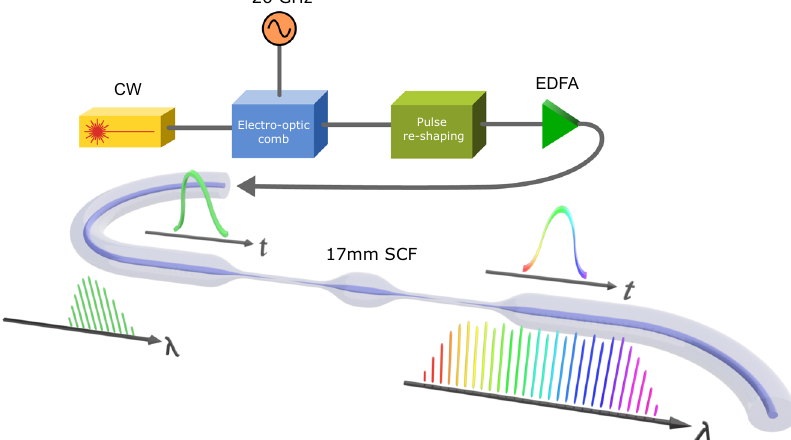
Fig. 2 Fully integrated SCF-based parametric comb generation scheme. An electro-optic frequency comb is generated to act as a seed source for the parametric mixing stage. A pulse re-shaping stage compresses the comb pulse train to maximise the pulse peak power and enhance the parametric mixing ef fi ciency. The optical output is then ampli fi ed and launched into a 17 mm sample of fully-integrated SCF, where parametric nonlinearities cause comb broadening. Both ends of the SCF are tapered and spliced to tapered single-mode fi bre, with nano-spike couplers to facilitate coupling between the heterogenous fi bre